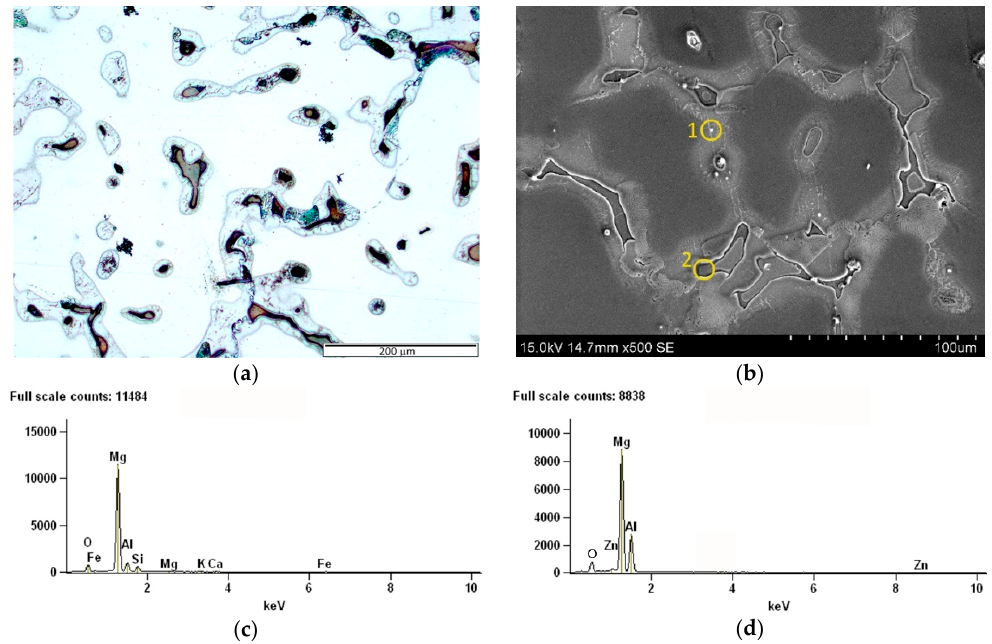
Figure 2. Microstructure of AZ91 alloy: ( a ) as-cast, ( b ) heat-treated.